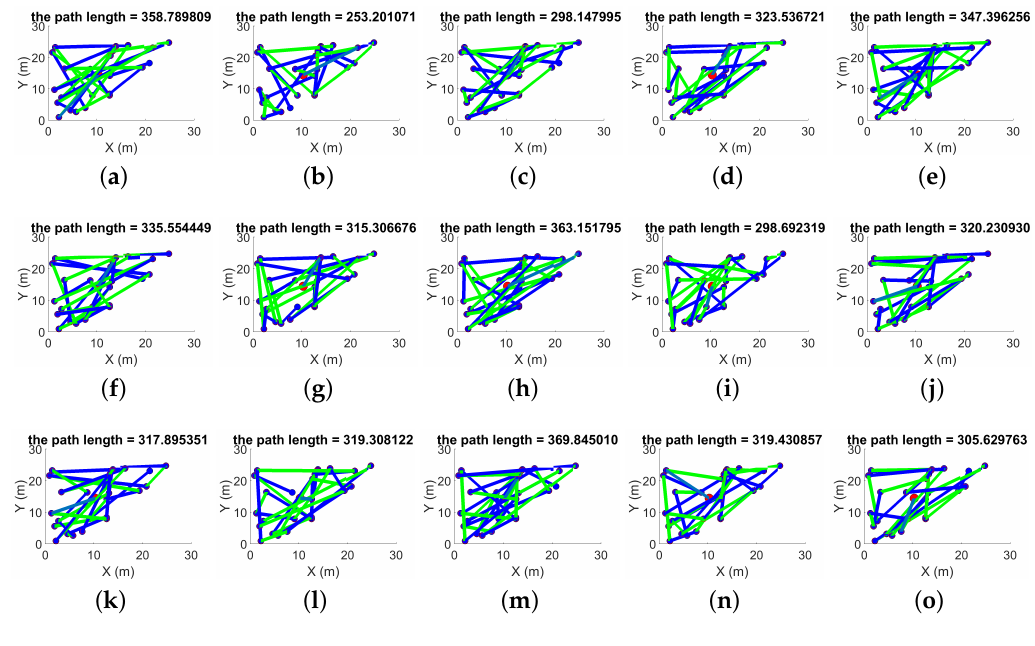
Figure 3. The constructed paths in iterations 1–15.